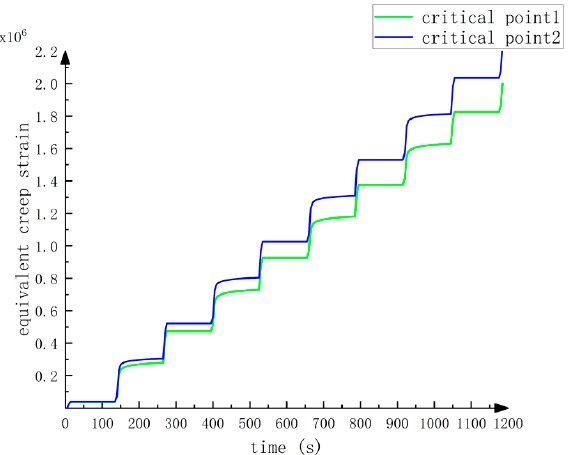
Figure 8. Creep strain development at a critical point.